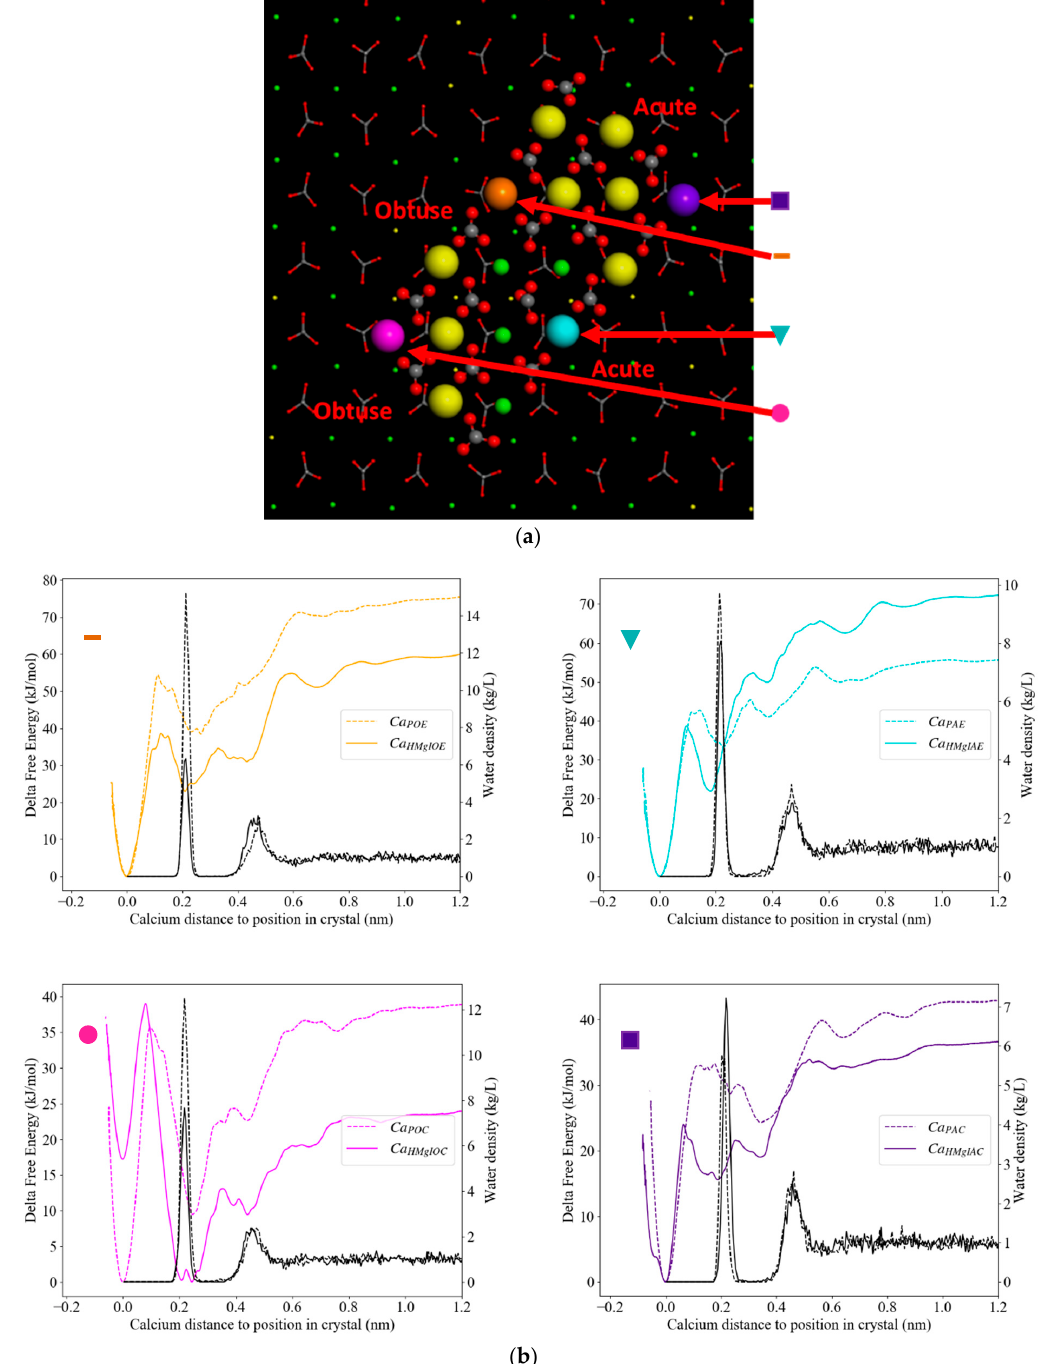
Figure 6. ( a ) Top view of the 4 × 8 atoms island on top of HMg 1014 surface with Mg 2+ in yellow, carbonate groups in grey (C) and red (O) and Ca 2+ in small green or colour and symbol coded larger spheres to link them to the free energy profiles in orange (obtuse edge, ▬ ), turquoise (acute edge, ▼ ), pink (obtuse corner, ● ) and purple (acute corner, ). ( b ) Overlay of free energy profile with the water density along the same axis. The dashed line represents the results for the equivalent calcium site in the pure system, i.e., the Ca 2+ are in a similar position as in (a), but no Mg 2+ is present in the surface.